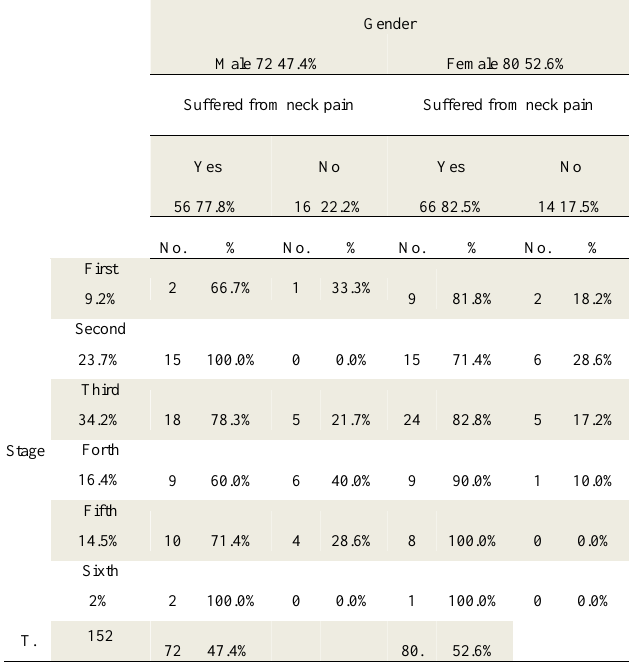
82.5% of females had a neck pain. (Tab 1) Table (1): Show the frequency of pain among students of different